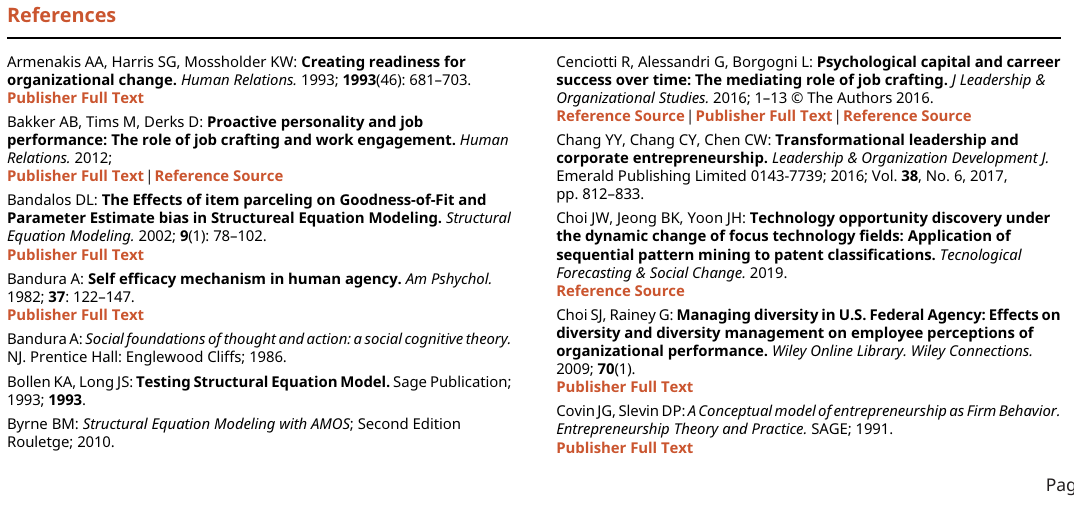
Figshare: Dataset of Questionnaire Result from the respondents of Transformational Entrepreneurship, Readiness to change, Psychological Capital, and Employee Performance. https://doi.org/10.6084/m9.figshare.14267393.v4 (Gunawan et al., 2021a).